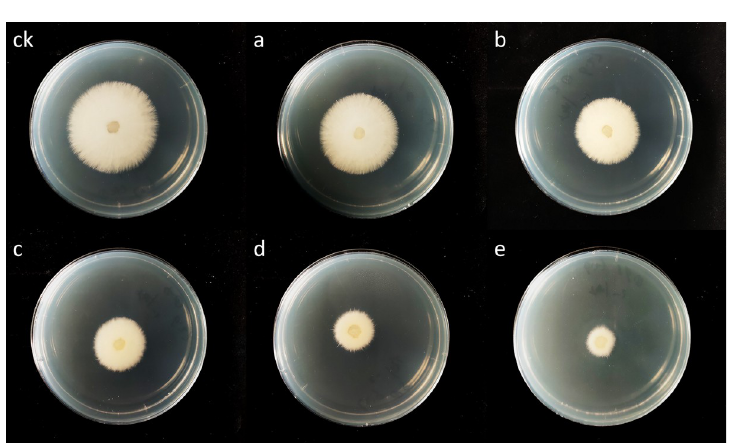
Fig 1. Inhibition effect of canthin-6-one on mycelium growth (72 h). ck, blank control; a–e, treatment with 1.0, 2.0, 4.0, 8.0, 16.0 μ g mL -1 canthin-6-one, respectively.